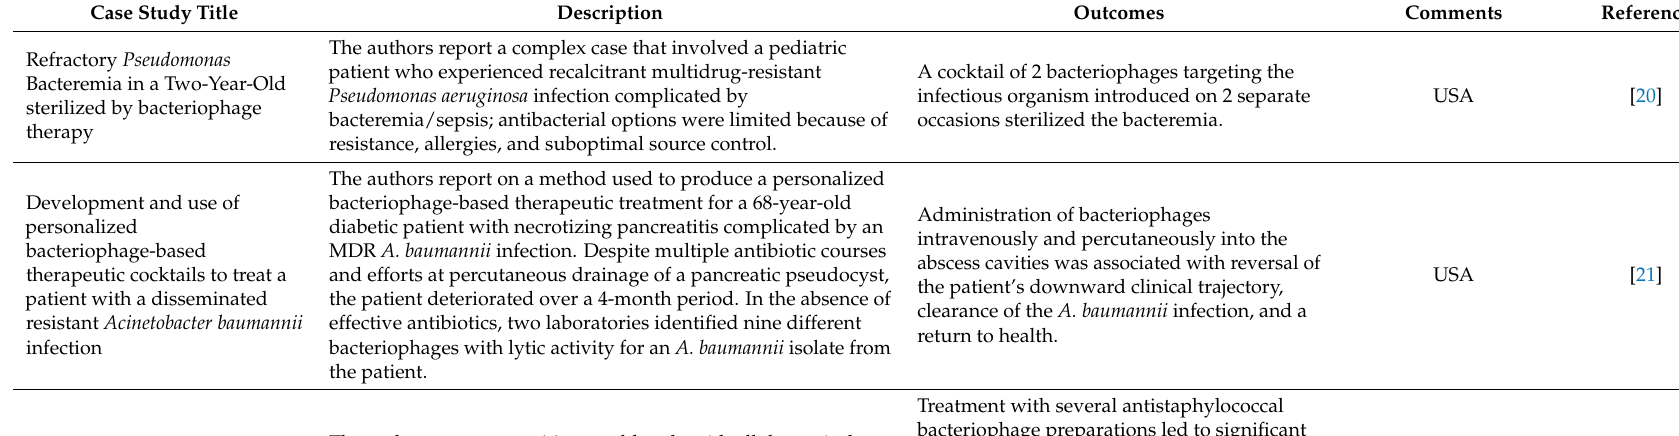
Table 2. Human bacteriophage therapy related case studies published in peer-reviewed English-language scientific literature over the last ten